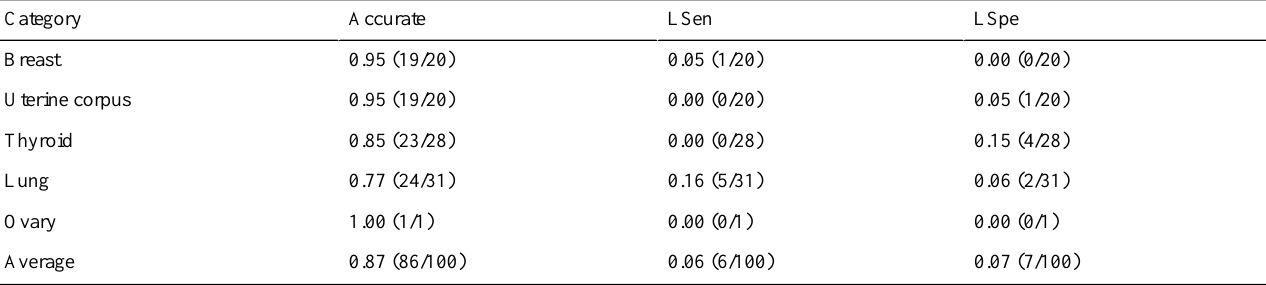
Table 6. Accuracy of diagnosis based on scanner VS by pathologist D. Results are presented as ratios between 0.00 and 1.00. LSpeLSenAccurateCategory